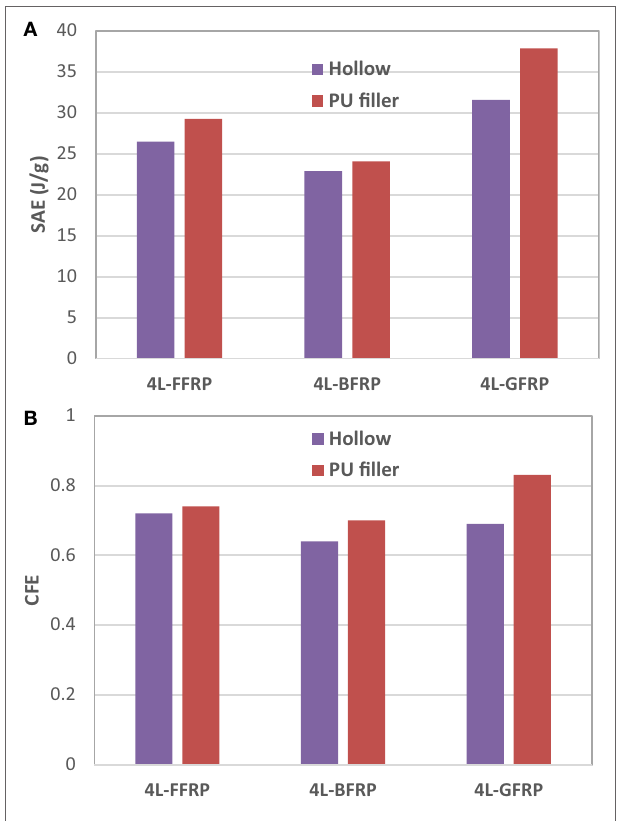
FigUre 7 | Effect of foam filler on (a) specific absorbed energy (SAE) and (B) CFE of 4-layer flax FRP (FFRP), 4-layer basalt FRP (BFRP), and 4-layer glass FRP (GFRP)